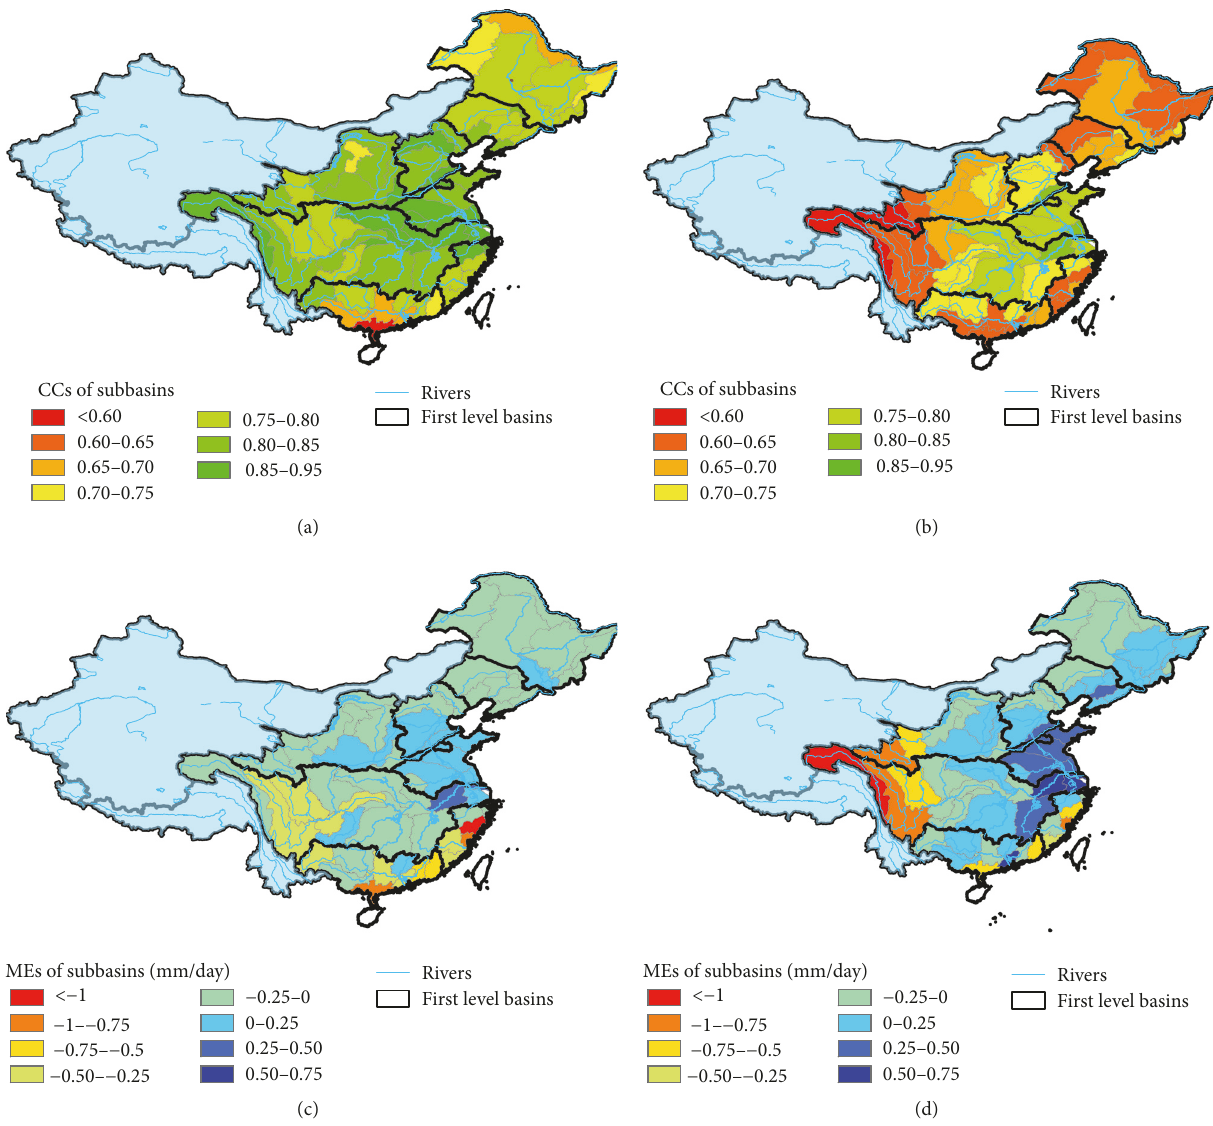
Figure 8: CC and ME distributions over 58 subbasins (included in eight main basins of eastern China) at the daily scale from April 2014 to March 2016: CC for (a) GSMap-gauged and (b) IMERG; ME for (c) GSMap-gauged and (d) IMERG.